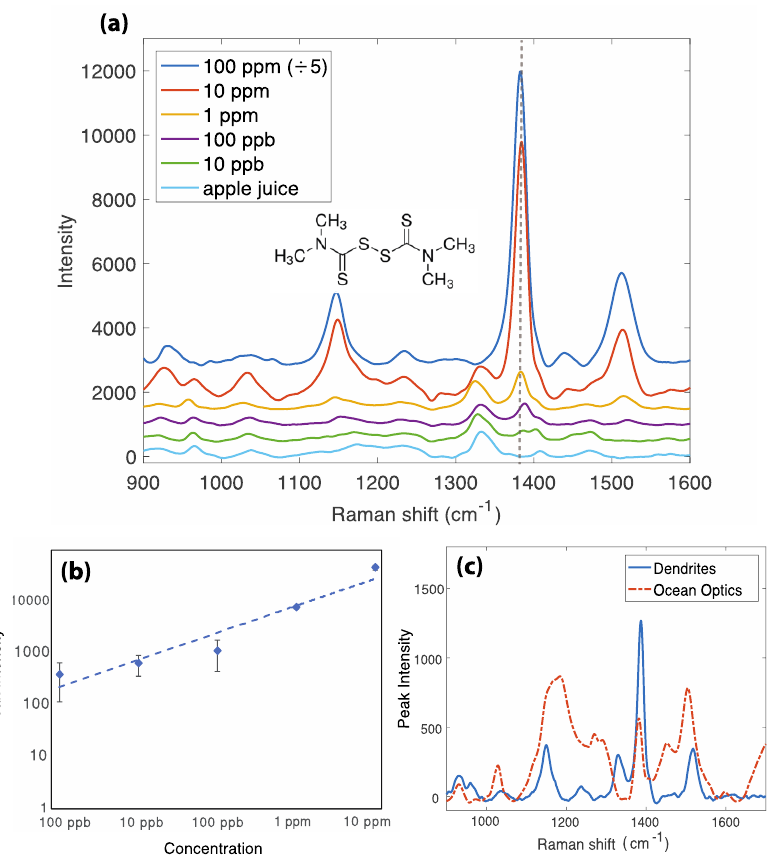
Figure 3. The results for thiram detection in apple juice. ( a ) SERS spectra of thiram at varying concentrations, in unprocessed apple juice. The key peak at 1384 cm − 1 is used for identification and quantification. ( b ) A log–log calibration curve of thiram in apple juice. Regression analysis yields y = 2520 · x 0.5209 , with an R 2 value of 0.9223. ( c ) A comparison between the SERS spectra of thiram in apple